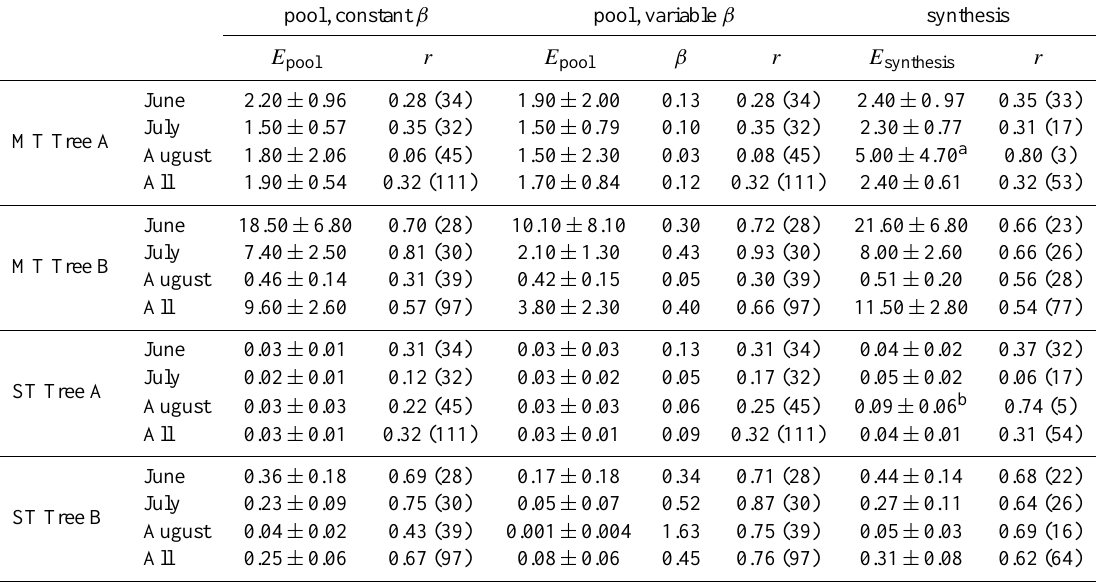
Table 2. The calculated emission potentials E pool and E synthesis ( µ g g − 1 h − 1 ) of mono- (MT) and sesquiterpenes (ST) at standard conditions dw (30 ◦ C and 1000µmolphotonsm − 2 s − 1 ) using a temperature-dependent pool algorithm (Guenther et al., 1993) and a temperature- and light- dependent synthesis algorithm (Guenther, 1997). The pool emission potential was determined in two different ways: by keeping the β value constant (0.09 ◦ C − 1 for mono- and 0.143 ◦ C − 1 for sesquiterpenes) and by keeping β as a free parameter. The correlation coefficient is indicated by r, and the number in the brackets illustrates how many data points were used for calculating the emission